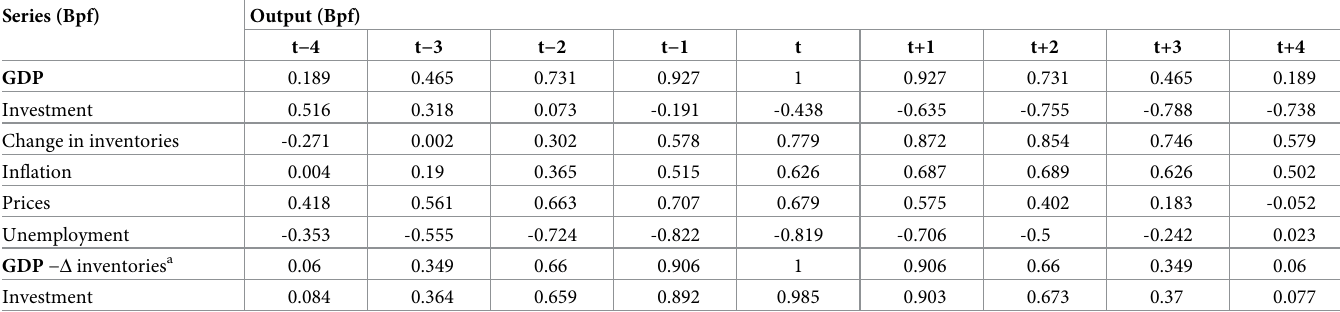
Table 2. Cross-correlation of macro variables—SF3.